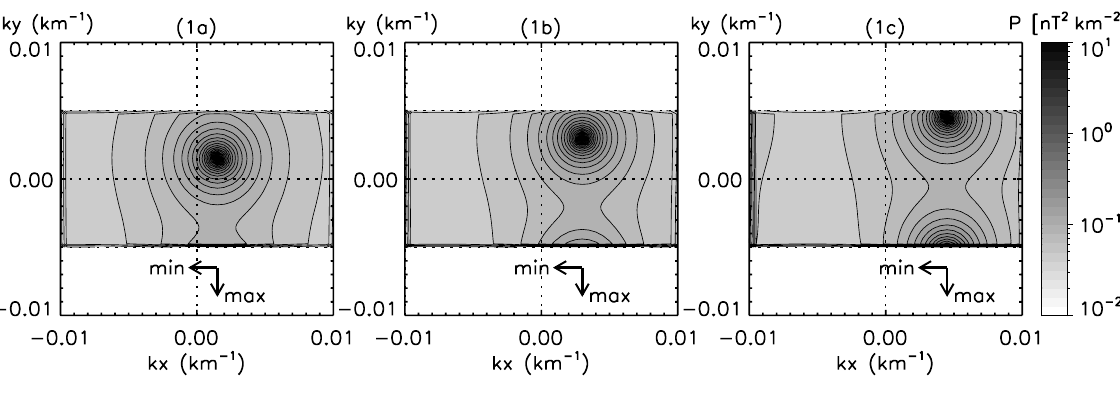
Fig. 6. Aliased spectra in the wave vector domain including both the true and the aliases spectrum for different peak positions of the true spectrum shifted in the Brillouin zone. Peak near the origin (left), at an intermediate distance to the border of the Brillouin zone (middle), near the border (right). Reciprocal vectors are orthogonal to each other and the Brillouin zone forms a rectangular cell.